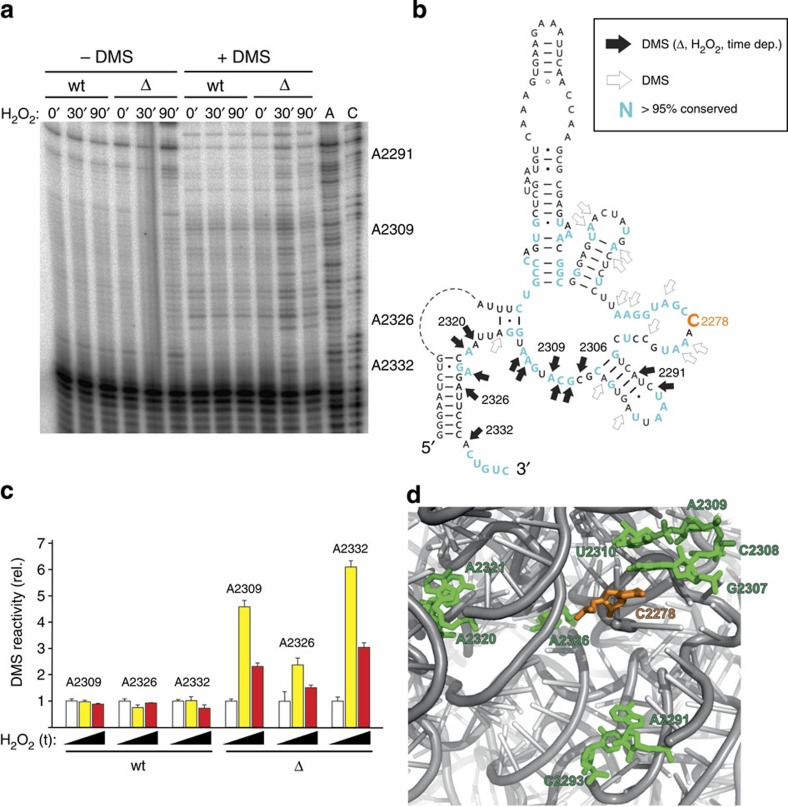
Loss of Rcm1 leads to structural changes of rRNA on oxidative stress.(a) Primer extension analysis of 25S rRNA of DMS-treated ribosomes. Ribosomes from wt and rcm1-knockout cells (Δ) were treated with H2O2 for 0, 30 or 90 min and subsequently analysed for DMS-reactive adenosines and cytidines. Note that the reverse transcriptase stops one nucleotide 3′ of the modified nucleobase. A and C denote dideoxy-sequencing lanes of untreated 25S rRNA and serve as marker for identifying DMS-reactive sites at the nucleotide resolution level. The positions of some DMS-reactive adenosines are indicated on the right. (b) Secondary structure diagram of the 25S rRNA region surrounding position C2278 (orange). DMS-reactive sites that change their reactivity only in the knockout strain during stress in a time-dependent manner are indicated by solid arrows. Additional positions that can be modified by DMS but do not show a differential pattern are indicated by open arrows. Nucleobases that are universally conserved (>95% conservation) in all three domains of life as well as in chloroplasts and mitochondria are highlighted in cyan. (c) Quantification of the DMS reactivity at selected rRNA positions in wt and rcm1-knockout (Δ) cells. The primer extension stop intensities of DMS-reactive nucleobases in the absence of H2O2 was taken as 1.0 and compared with the corresponding bands in ribosomes treated with H2O2 for 0 (white bars), 30 min (yellow bars) or 90 min (red bars). Values shown represent the mean and the s.d. of three independent DMS-probing experiments. (d) Three-dimensional representation of the structural proximity of C2278 (shown in orange) with DMS-reactive residues that showed a temporal enhanced accessibility after 30 min of H2O2 stress (green). The three-dimensional architecture was generated from pdb file 35UI.